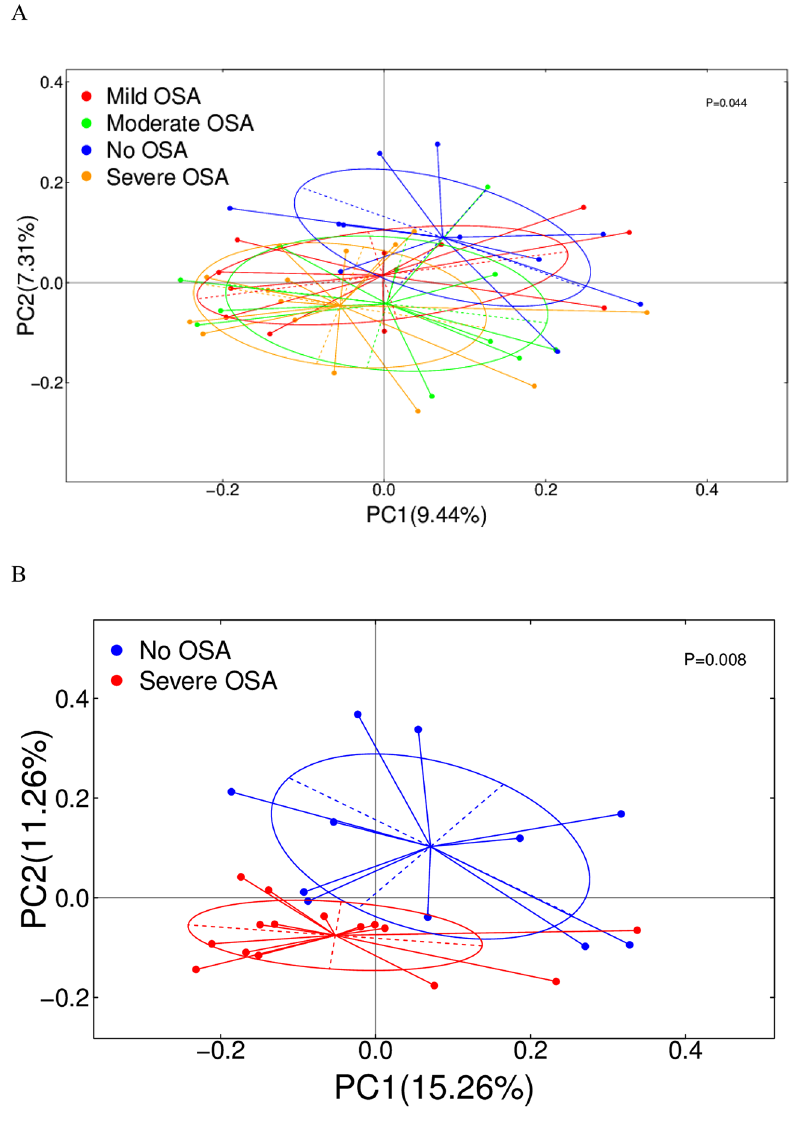
Figure 3. β diversity differences in different severity groups of OSA and severe OSA. PCOA (Unweigther- Unifrac distance) between ( A ) different severity groups of OSA versus no OSA (Adonis P = 0.044) and ( B ) severe OSA versus no OSA (adonis P =